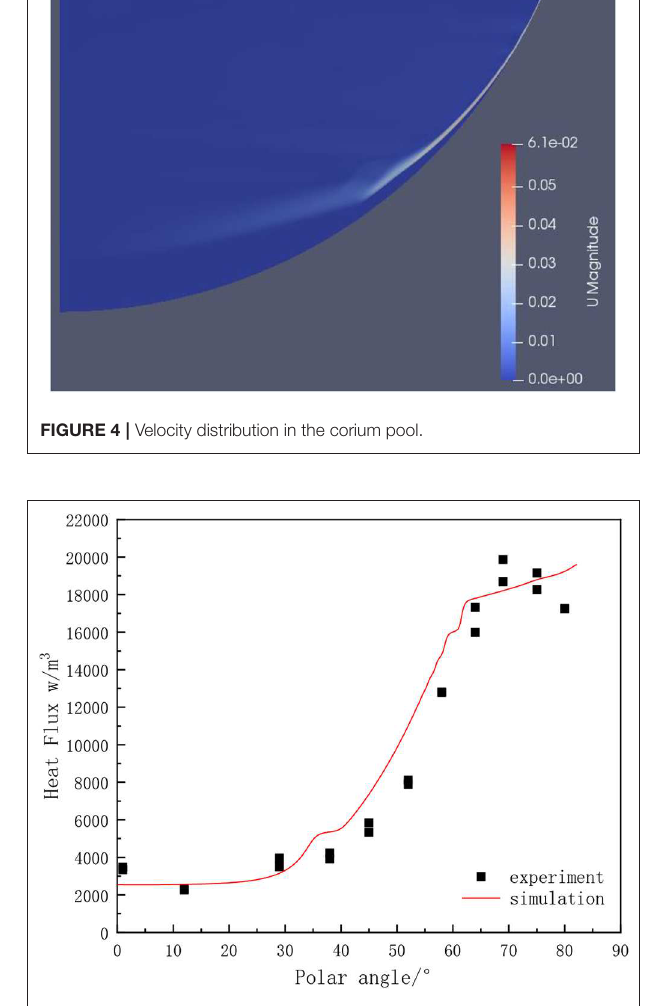
FIGURE 5 | Comparison of experimental and simulated heat flux